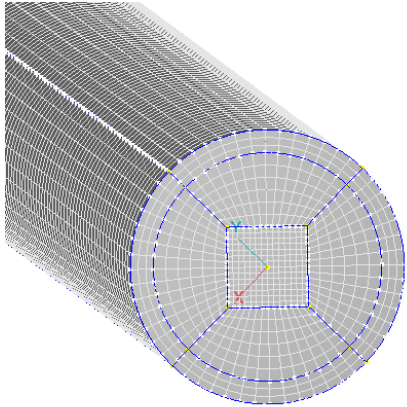
Figure 3. Grid division for the tube cross-section.